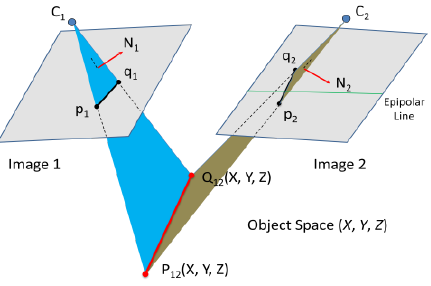
Fig. 2 The reconstruction of the line segments that are not aligned with the epipolar line.